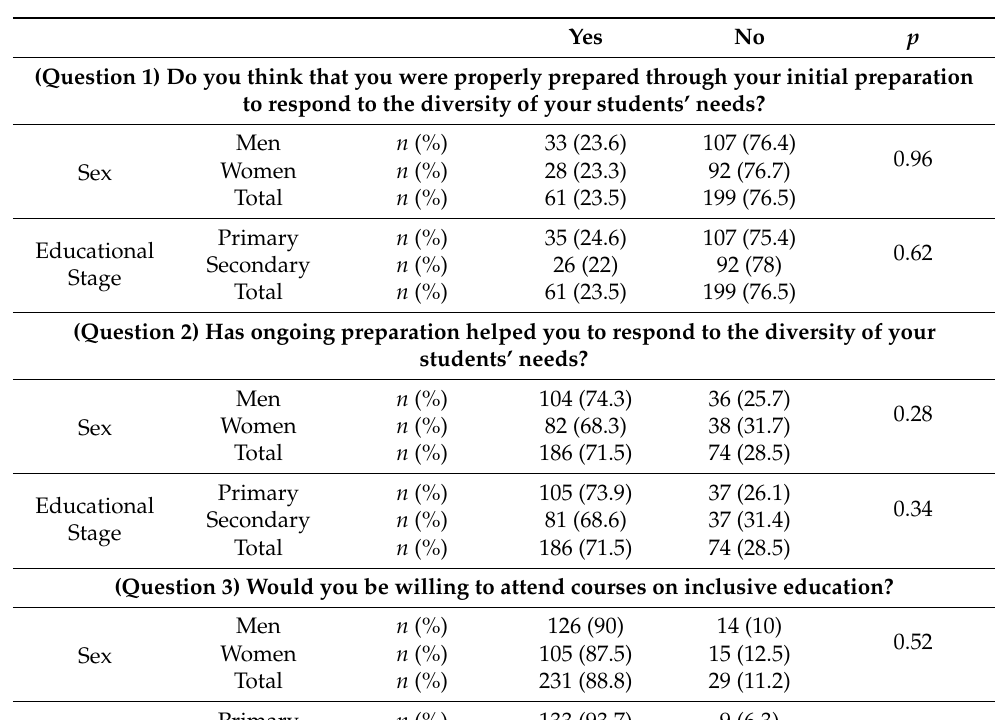
Table 2. Distribution of the three dichotomous questions and responses according to sex and educa- tional